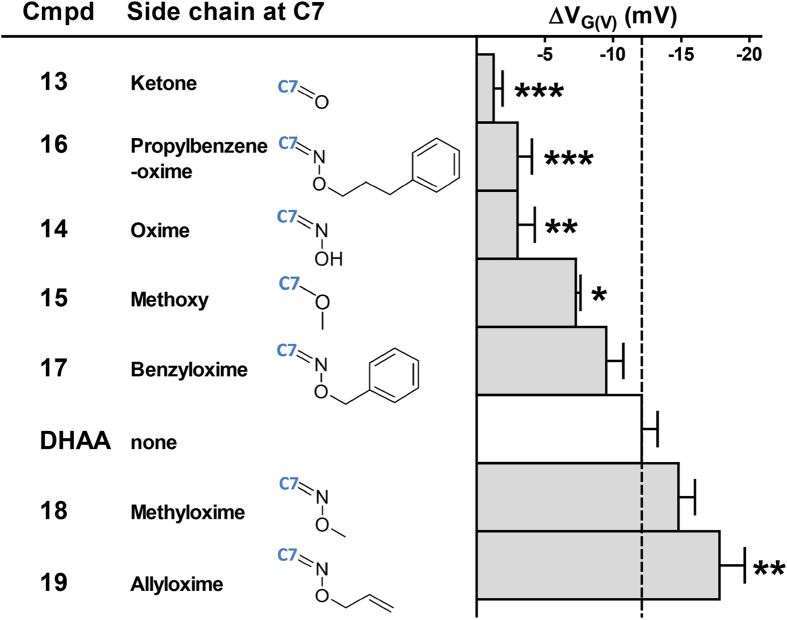
The effect of modifications of C7 at the B-ring for the activation of the 3R Shaker K channel.Chemical side chain and molecular structure for the introduced side chain at C7 of DHAA (4) (middle) for the specific compound (left). Compound(100 μM)-induced G(V) shifts for the 3R Shaker K channel (right). The dashed line equals the DHAA-induced shift. Mean ± SEM (n = 4–6). The shifts are compared with DHAA (4) (one-way ANOVA together with Dunnett’s multiple comparison test: *P < 0.05; **P < 0.01; ***P < 0.001).